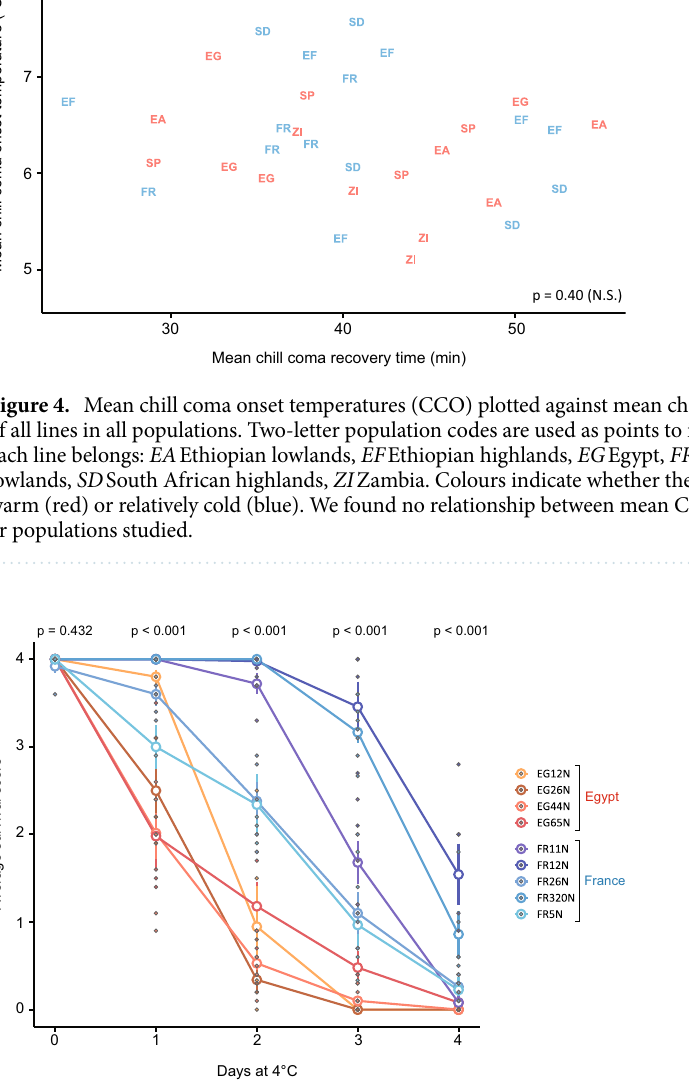
Figure 5. Average survival score after exposure to 4 °C for between zero and four days for four Egyptian lines and five French lines. Each point represents a single replicate: the average survival score of a vial of approximately ten flies. A survival score of zero meant that a fly was not moving, whereas a survival score of four meant it was climbing and/or flying. Survival scores were recorded 24 h after removal from the cold (or 24 h after the beginning of the experiment, in the case of flies that were not exposed to 0 °C). Open circles represent line means, and error bars represent standard errors. Some error bars are too small to be visible. p values from population comparisons on each day are given at the top of the